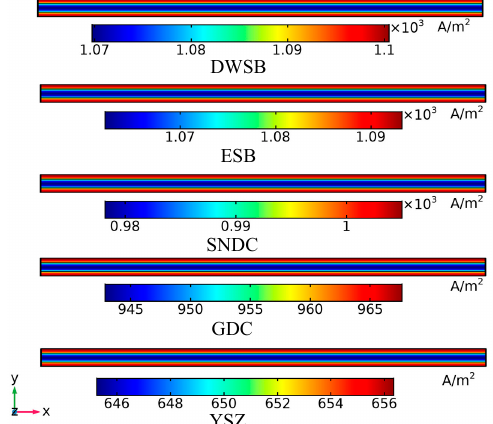
Figure 5. Current density distributions of the different electrolytes.